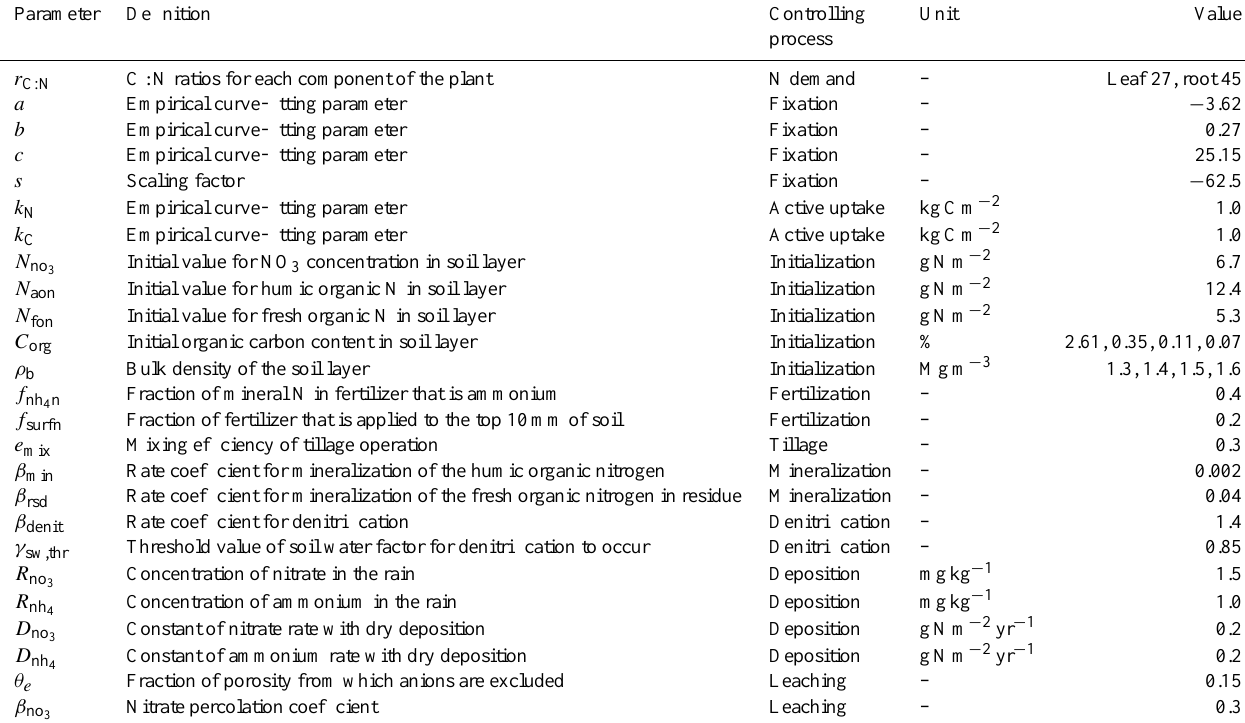
Table 1. Model input variables and